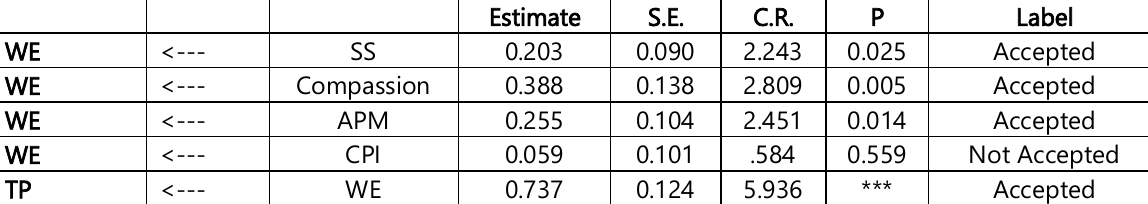
Table 6: Regression Weights (Source: Authors’ calculation)